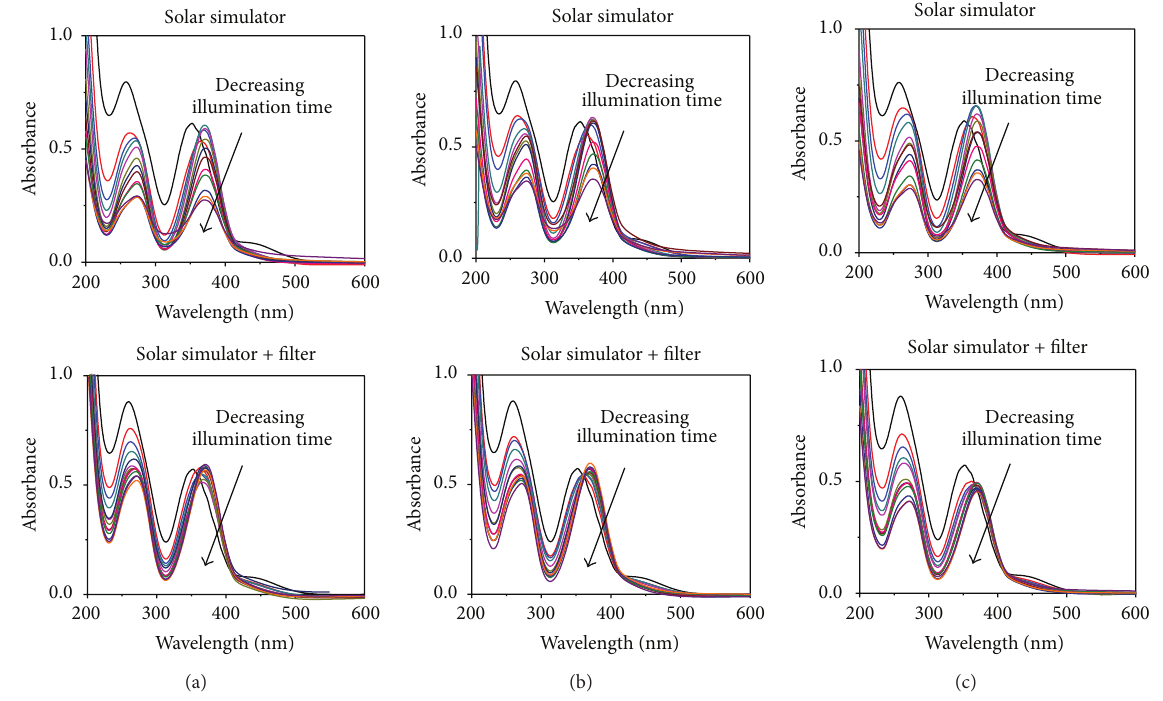
Figure 11: The absorbance spectrum of K 2 Cr 2 O 7 aqueous solution with various TiO 2 as photocatalysts as a function of illumination time: (a) 0% AC, (b) 5% AC, and (c) 10% AC. The solar simulator with xenon 150 W lamp with and without a filter was used as a light source.